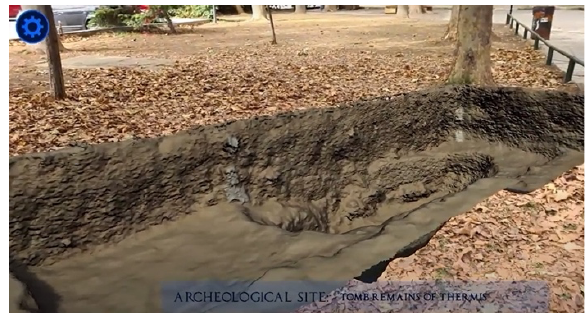
Figure 2 : Demo presentation of SmartEye